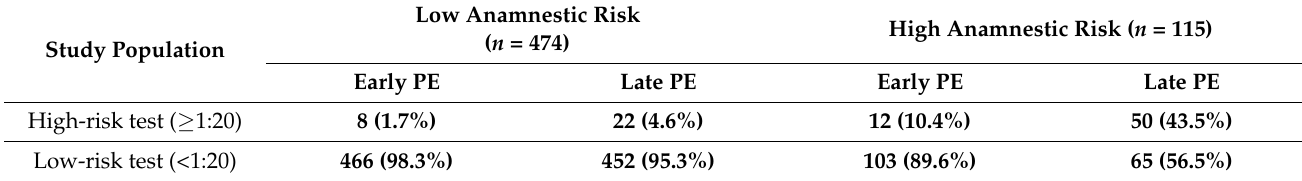
Table 5. Results of the multiparametric test in the study